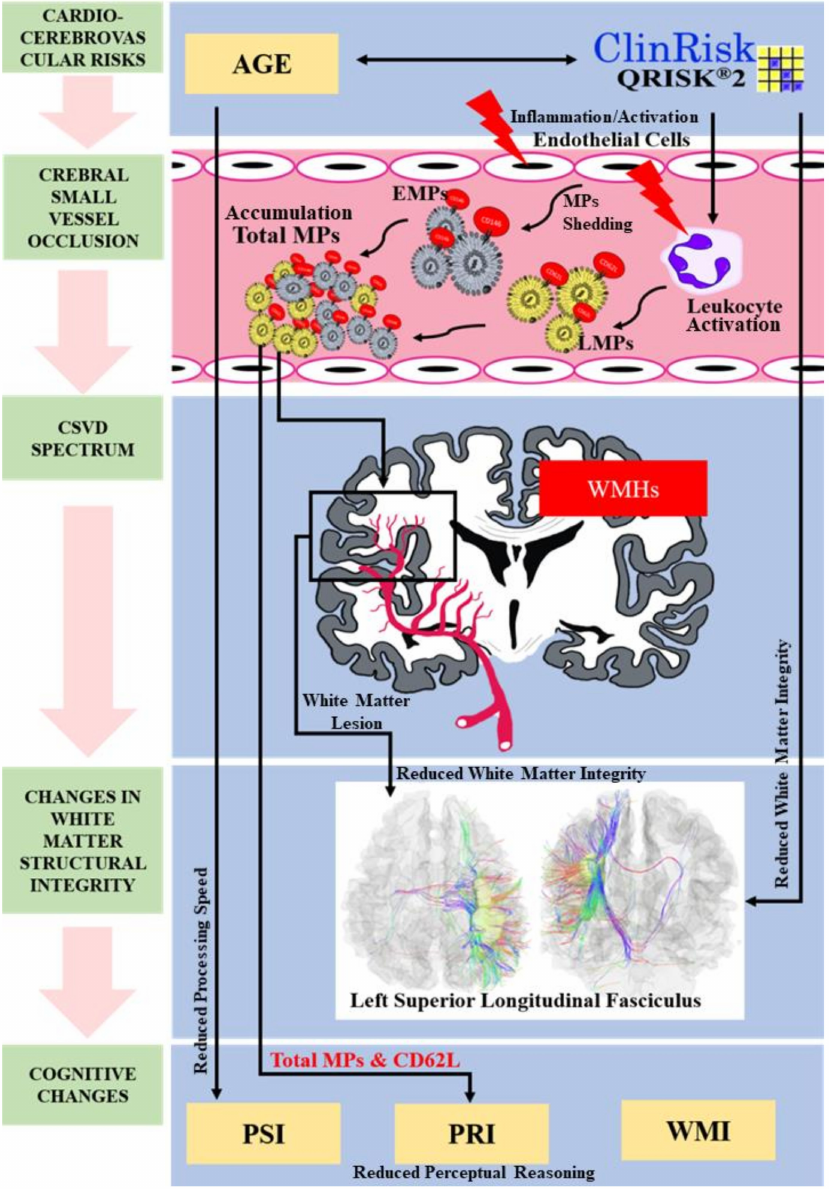
Figure 2. Multimodal linear relationship between surrogate markers: cardiocerebrovascular risk factors, such as age, are associated with QRISK2 and Wechsler Adult Intelligence Scale: Fourth edition (WAIS-IV) processing speed index (PSI). QRISK2 is associated with the leukocyte-derived MPs (LMPs; i.e., CD62L), whereas endothelial cell-derived MPs (EMPs; i.e., CD146) may exclusively be induced by other factors, inclusive of cardiocerebrovascular risk factors. LMPs and EMPs can potentially contribute to total MPs; hence, MP accumulation in cerebral small vessels (or end arteries) is thus postulated to cause occlusion. Such an occlusion may induce the formation of WMHs. LMPs, EMPs, and total MPs were associated with the integrity of the left superior longitudinal fasciculus (LSLF) regarding the presence of WMHs in that particular region. QRISK2 was also directly associated with the integrity of LSLF. Finally, total MPs and CD62L were exclusively associated with the WAIS-IV perceptual reasoning index